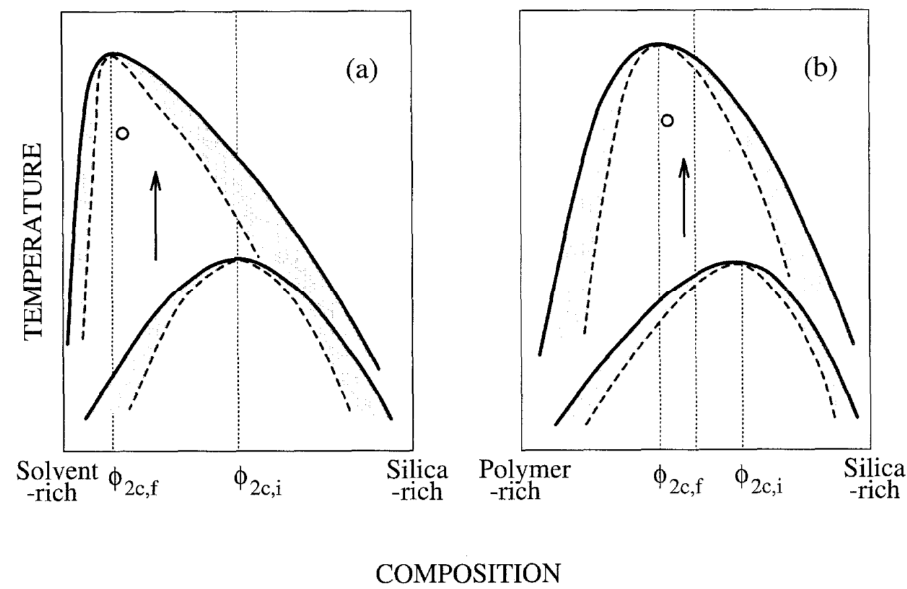
Figure 6. Schematic phase diagrams for the formamide system ( a ) and for an organic polymer containing system ( b ). φ C , i and φ C , f are critical compositions just after all the constituents are mixed and during phase separation, respectively. The value of φ C , f in the formamide system is much smaller (more silica-poor); additionally, binodal and spinodal lines are more asymmetric than those in HPAA system. Reprinted, with adaptations, by permission from Springer Nature Customer Service Centre GmbH: Springer, J. Sol-Gel Sci. Technology, Polymerization-induced phase separation in silica sol-gel systems containing formamide, Kaji H, Nakanishi K, Soga N, © Kluwer Academic Publishers. Manufactured in The Netherlands (2013) [20].